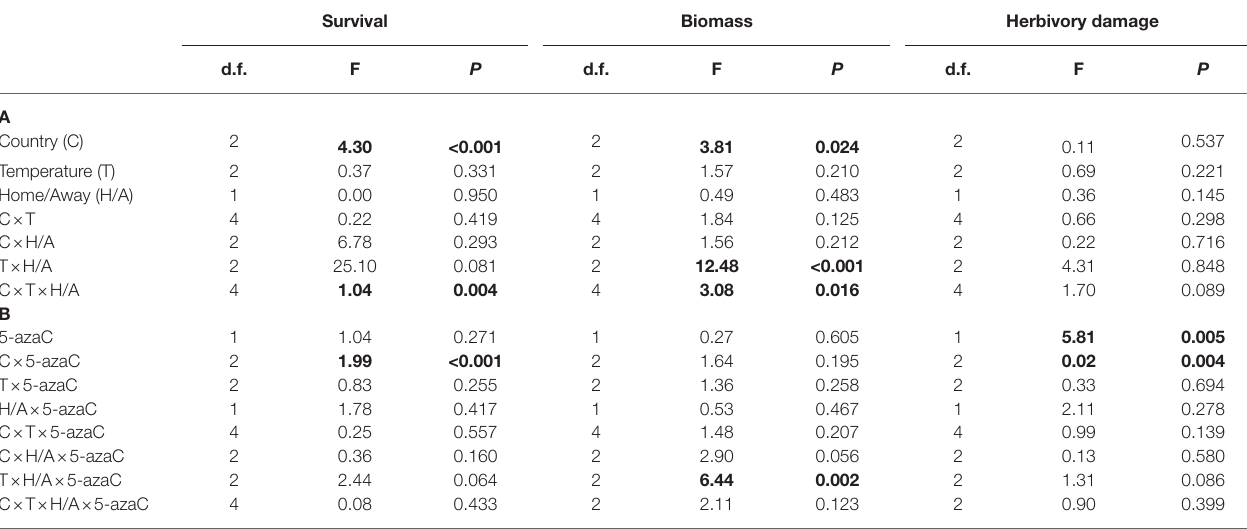
TABLE 2 | Test of local adaptation (Hypothesis 1; A) and role of DNA methylation in local adaptation (Hypothesis 2; B). Survival